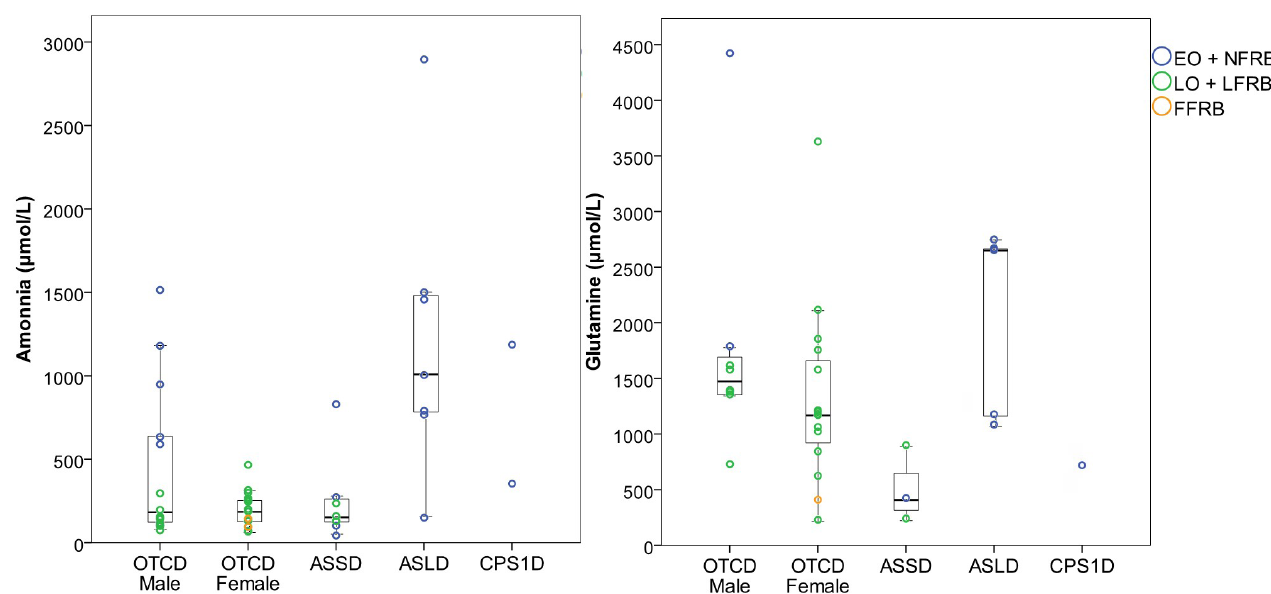
Figure 2. Ammonium and glutamine values according to enzyme deficiency. The distribution of the ammonium and glutamine values are shown in box plots for the OTC, ASS, and ASL deficiencies. Patients’ values are indicated as dots, stratified by type of onset.